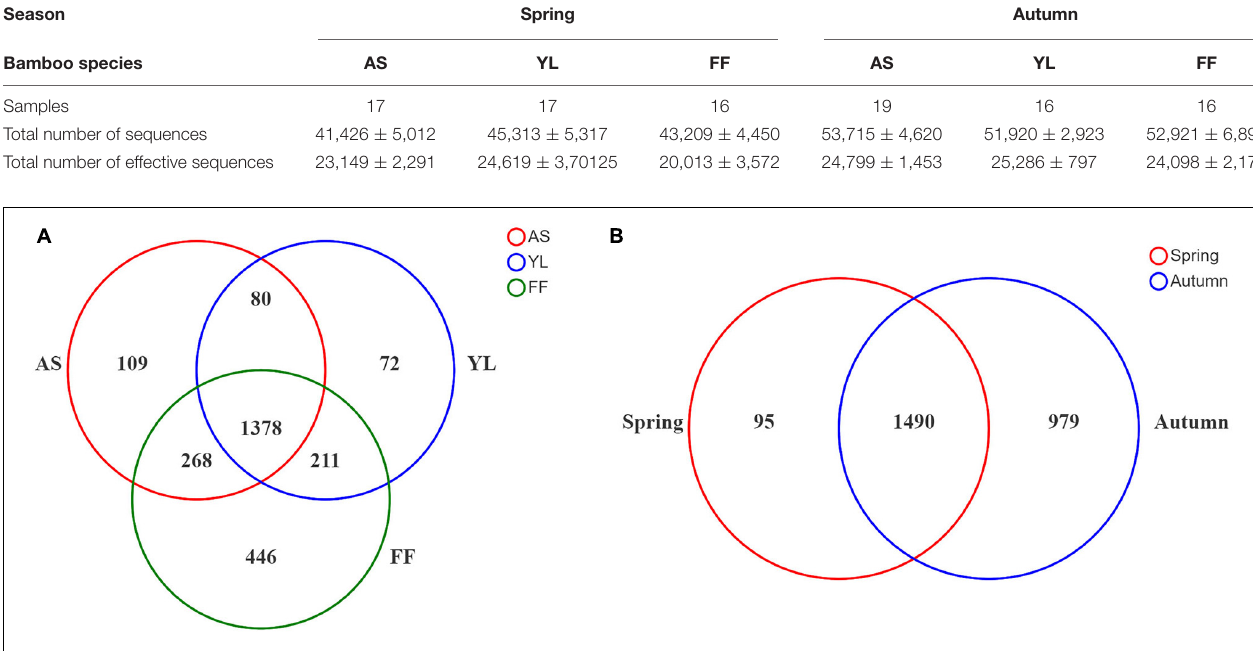
FIGURE 1 | Venn diagram showing overlap/non-overlap of phyllosphere bacteria OTUs among three bamboo species (A) and two seasons (B) . AS, A. spanostachya ; YL, Y. lineolate ; FF, F. ferax .